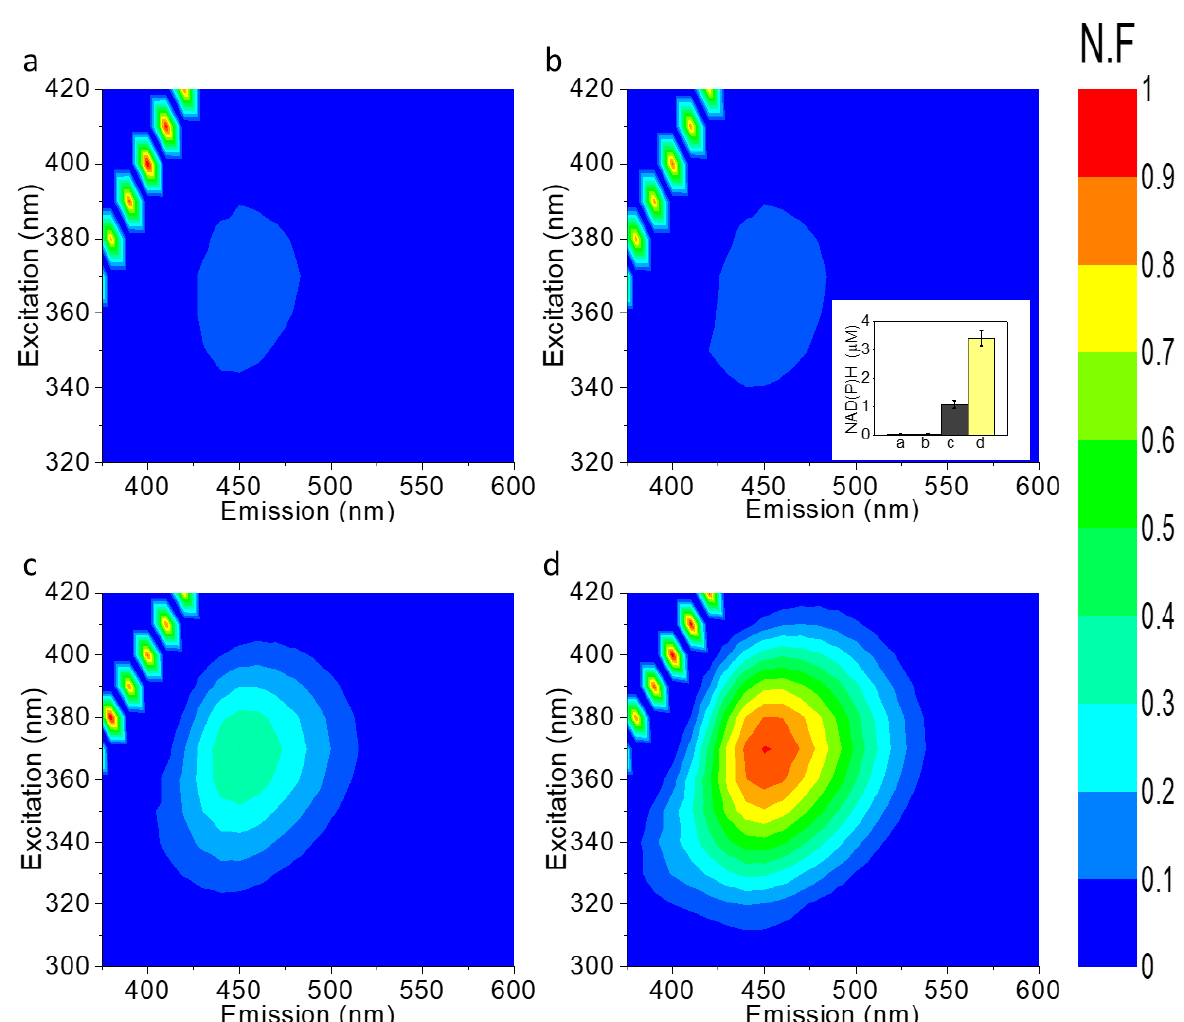
Figure 2. NAD(P)H accumulates in the external cellular media of Ds. 2D-FM spectra were measured for the ECM of Ds cells after 10 min in dark and light, with or without association to the anode. ( a ). ECM of DS in dark without association to the electrochemical cell. ( b ). ECM of Ds in light without association to the electrochemical cell. ( c ). ECM of Ds in dark with association to the electrochemical cell. ( d ). ECM of Ds in light with association to the electrochemical cell. The insert in panel b shows the NAD(P)H concentrations that were calculated based on the maximal fluorescence intensities at λ max = 340 nm [36]. The X axis labels of the insert are: a, dark without association to the anode; b, light without association to the anode; c, dark with association with the anode; and d, light with association with the anode, respectively. The error bars represent the standard deviation over three independent experimental repetitions.